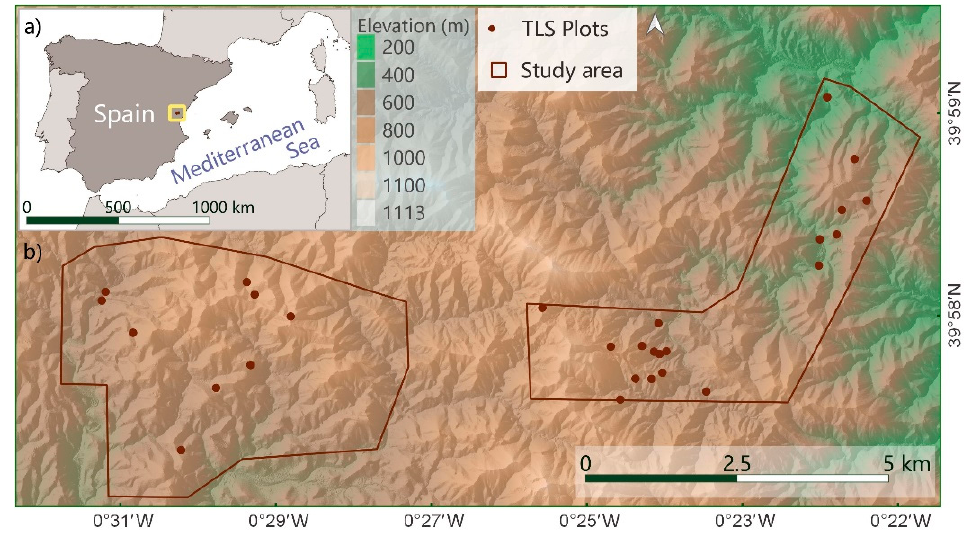
Figure 2. ( a ) General location of the study area in South-Western Europe, and ( b ) detailed plot locations (dark circles).